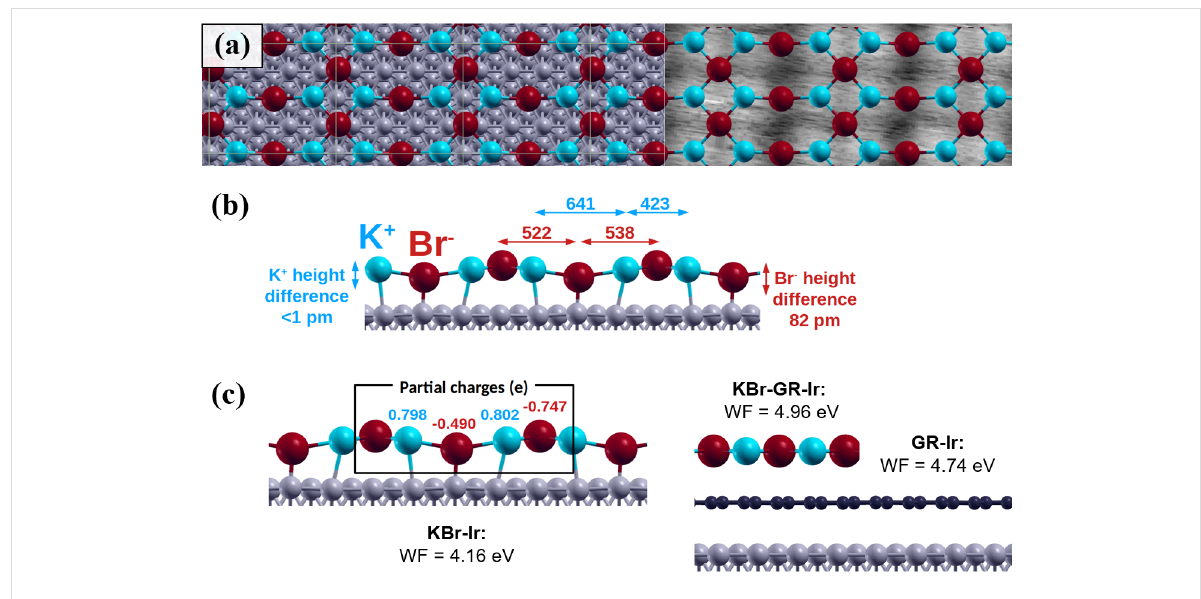
Figure 3: DFT simulation of a monolayer KBr on Ir(111). (a) Optimization of a reconstructed KBr layer on Ir(111) with a cell size of 4 × 2 superim- posed on the Ir(111) model and experimental data (Br − in red and K + in blue, the size of the atoms reflects their ionic radii). The interaction with the substrate induces a strong corrugation and distortion of the KBr layer, as shown in the side view in (b). (c) Partial charges and resulting work function (WF) of KBr on Ir(111), of KBr on GR/Ir(111), and of only graphene on Ir(111). For the corrugated KBr layer a significant decrease of work function is observed, while the work function increases when a graphene layer is present between KBr and Ir(111).